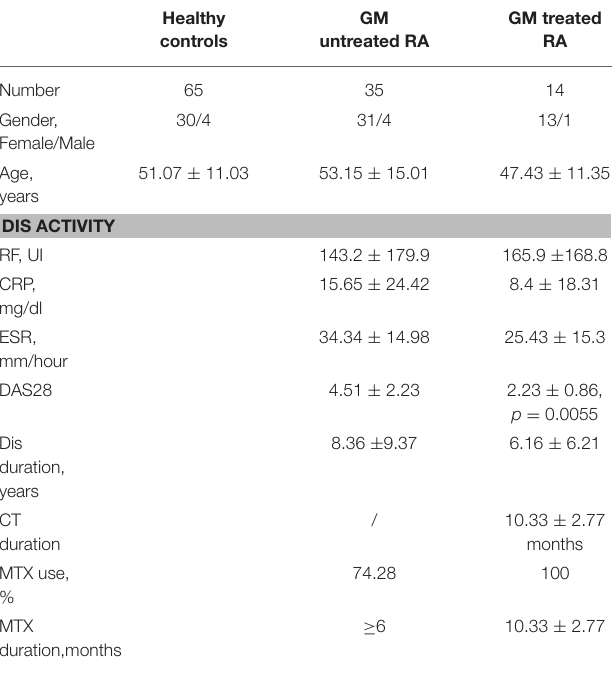
TABLE 1 | Characteristics of HC and RA